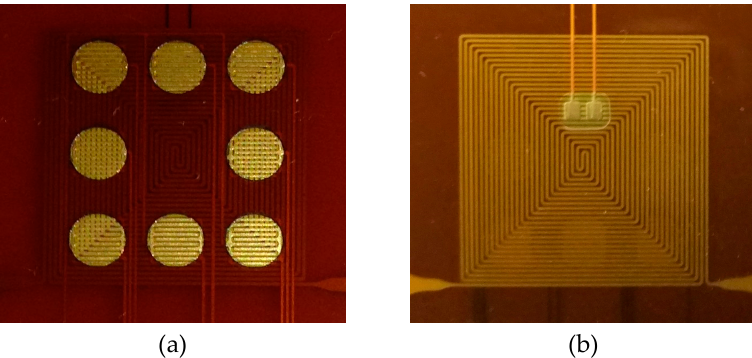
Figure 7. Schematic of the gas sensor equipped with a thermostat. ( a ) front photograph of gas sensor; ( b ) reverse photograph of gas sensor.